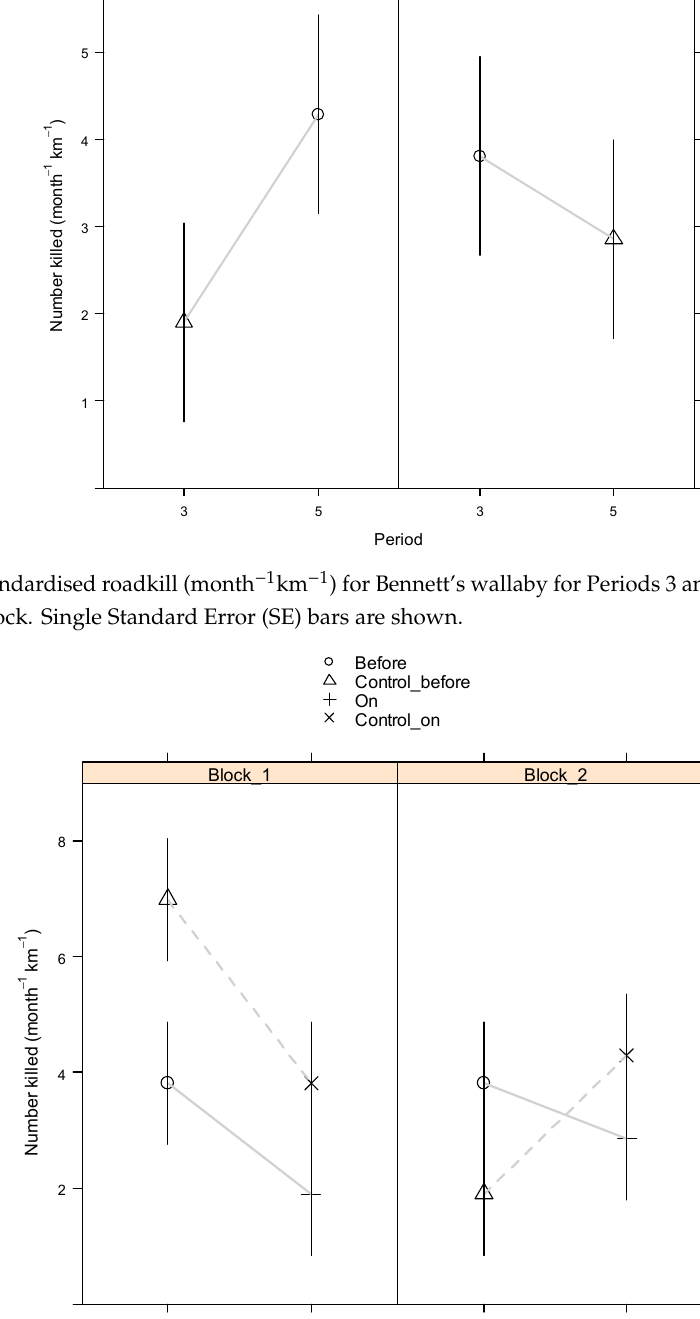
Figure 2. Standardised roadkill rate (month − 1 km − 1 ) for Bennett’s wallaby for Periods 2 to 5 for MBACI means by Block. Single SE bars are